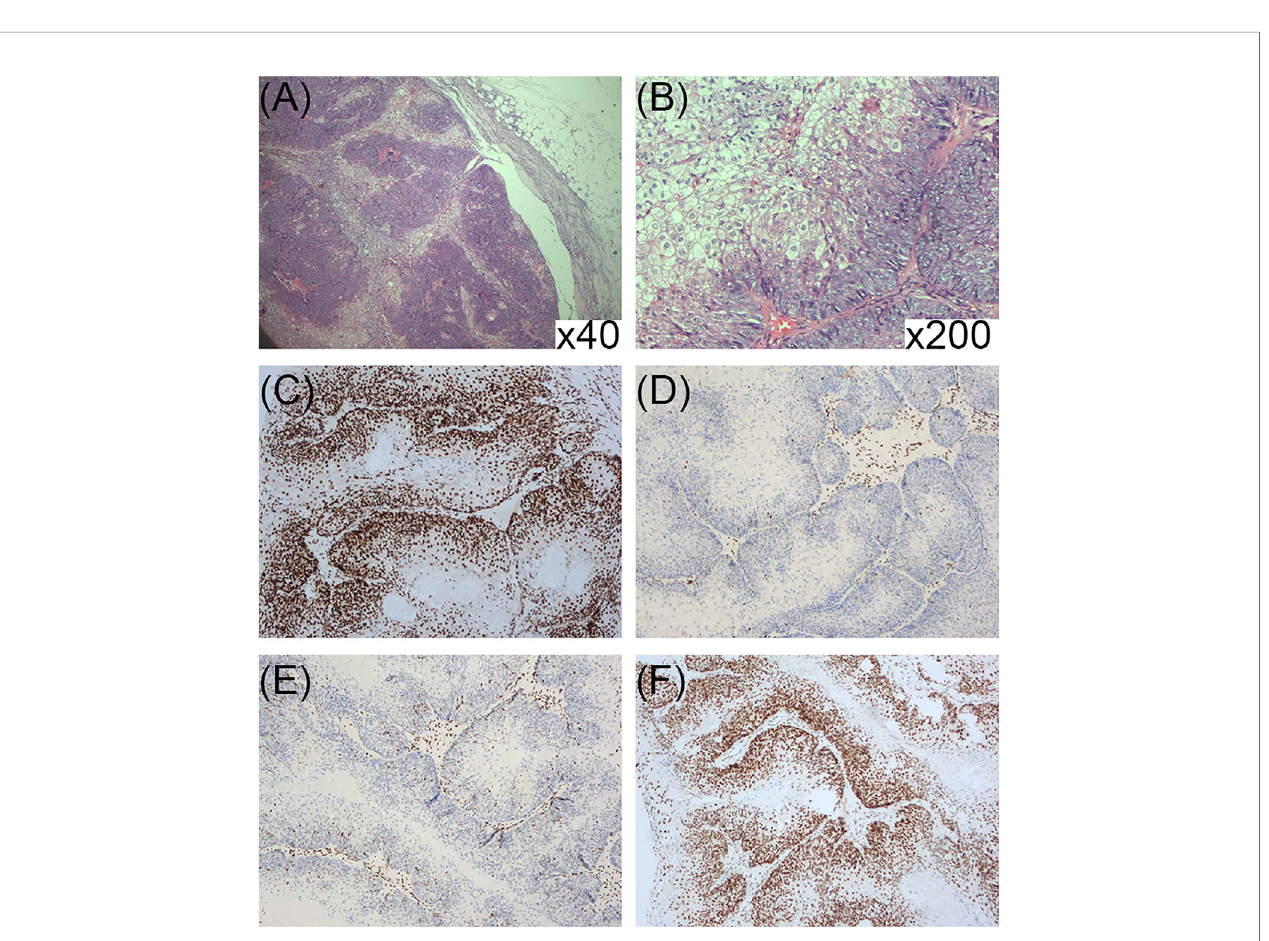
FIGURE 3 | (A, B) Pathological presentation of sebaceous carcinoma on the chest: (A) Tumor cells formed nests or lobules of different sizes, with clear boundary and capsule (HE ×40). (B) The tumor was composed of basal-like cells and vacuolated sebaceous cells, some of which had large, hyperchromatic nuclei (HE ×200). (C – F) Immunohistochemical staining for DNA mismatch repair proteins (MMR proteins MLH1, MSH2, MSH6, and PMS2) of the sebaceous carcinoma; (C) Normal nuclear expression of MLH1 protein. (D) Lack of nuclear expression of MSH2 protein. (E) Lack of nuclear expression of MSH6 protein. (F) Normal nuclear expression of PMS2 protein.